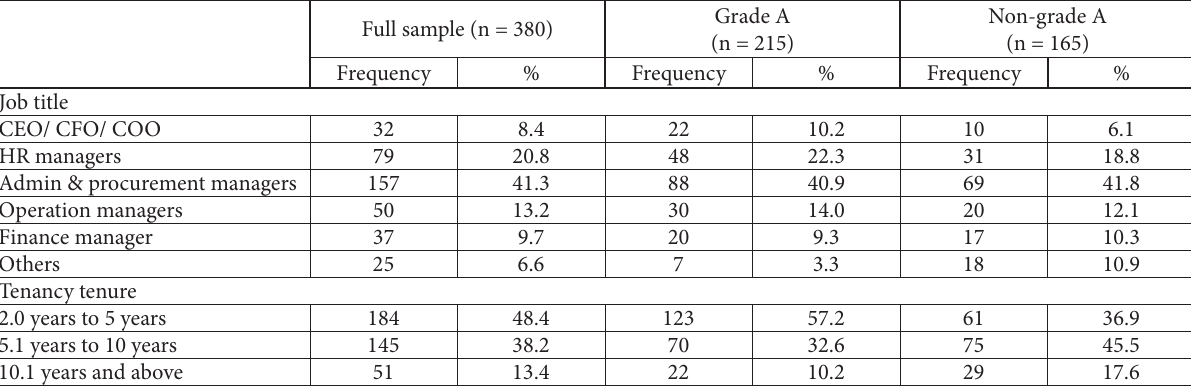
Table 1. Demographics statistics of the sample